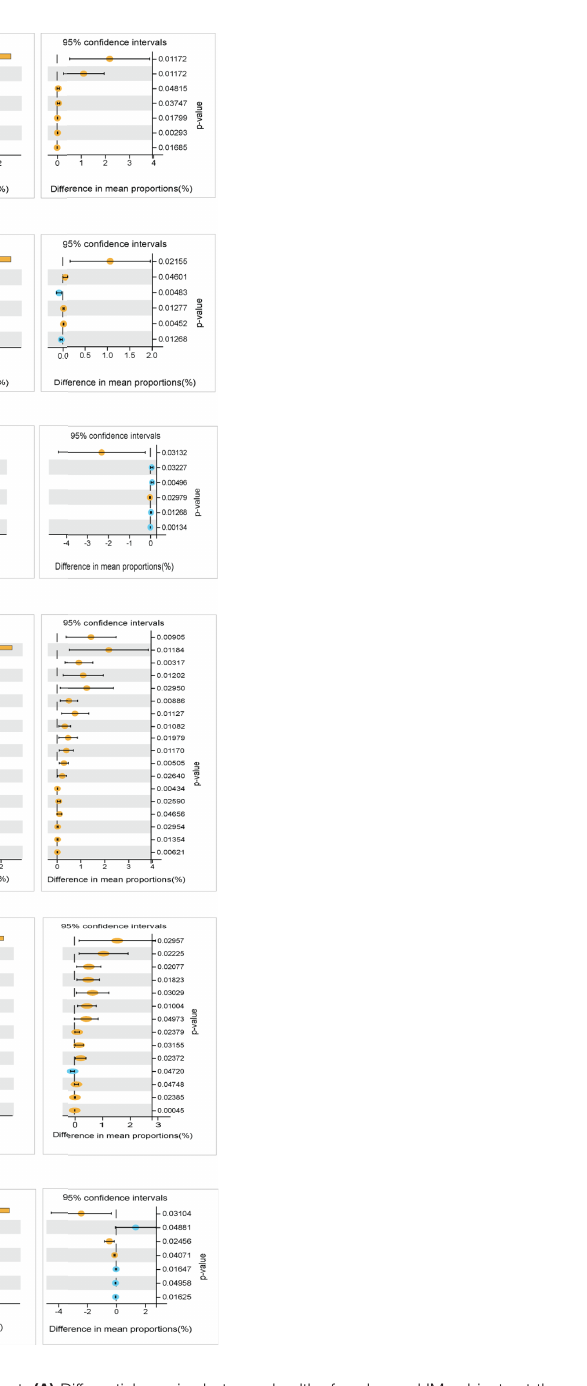
FIGURE 5 | Species analysis of differences between groups analyzed by Welch ’ s t-test. (A) Differential species between healthy females and IM subjects at the family levels. (B) Differential species between healthy females and CC subjects at the family levels. (C) Differential species between IM subjects and CC subjects at the family levels. (D) Differential species between healthy female subjects and IM subjects at the genus levels. (E) Differential species between healthy female subjects and CC subjects at the genus levels. (F) Differential species between CC subjects and IM subjects at the genus levels. In each fi gure, the left panel shows the abundance of differences in species between groups, and each bar in the graph represents the mean of each species in each group, with signi fi cant differences in abundance between groups. The graph on the right shows the difference in con fi dence levels between groups. The leftmost endpoint of each circle in the fi gure represents the 95% con fi dence interval lower limit of the mean difference, and the rightmost endpoint of the circle represents the 95% con fi dence interval upper limit of the mean difference. The center of the circle represents the difference in the mean. The group represented by the circle color is a group with a higher mean. At the far right of the displayed results is the inter-group signi fi cance Welch ’ s t-test p-value for the corresponding